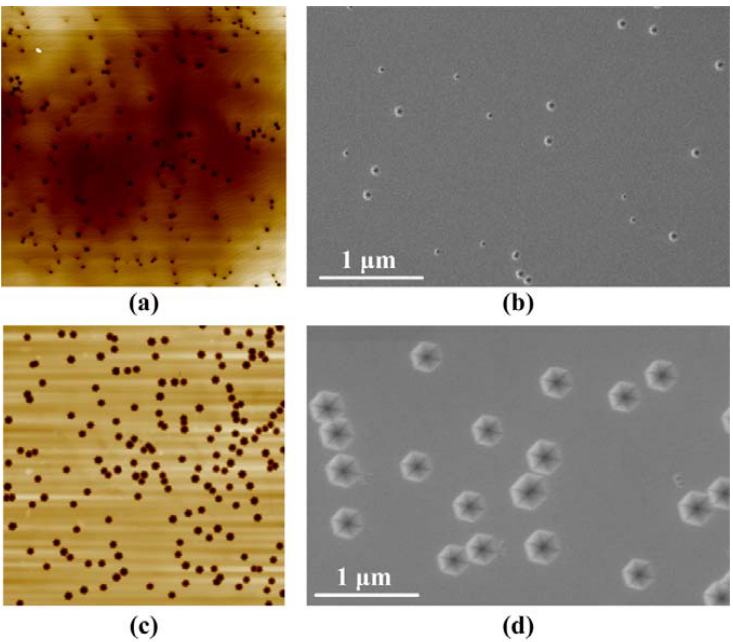
Figure 2. The 10 μ m × 10 μ m AFM and morphological SEM images of samples. ( a , b ) without an Figure 2. The 10 µ m × 10 µ m AFM and morphological SEM images of samples. ( a , b ) without an InGaN/GaN SL; ( c , d ) with an InGaN/GaN SL. InGaN/GaN SL; ( c , d ) with an InGaN/GaN